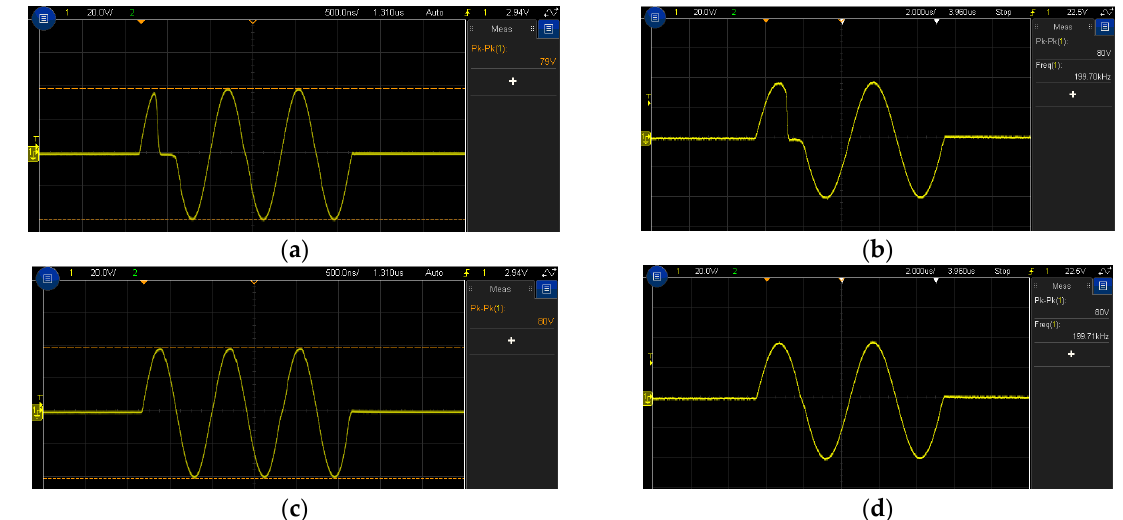
Figure 8. Scope screenshots of transmission bursts measured at the load for the 2 tested transformers. The PE65968NL was excited by 3 cycles at 1.2 MHz ( a , b ), and the 78602/2JC with 2 cycles at 200 kHz ( c , d ). In ( a , c ), the prefluxing circuit is not active, while in ( b , d ), it is active. Output is 80 Vpp in all 4 measurements. Table 3. Lowest limit improvement achievable with prefluxing circuit.